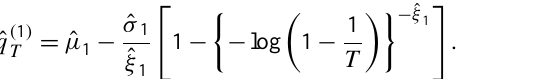
Fig. 1. Scatter plot of GEV location parameters ( µ ) against scale parameters ( σ ) estimated for every station. The line added corresponds to linear regression. Fig. 2. Scatter plot of 100-year return levels estimated locally versus